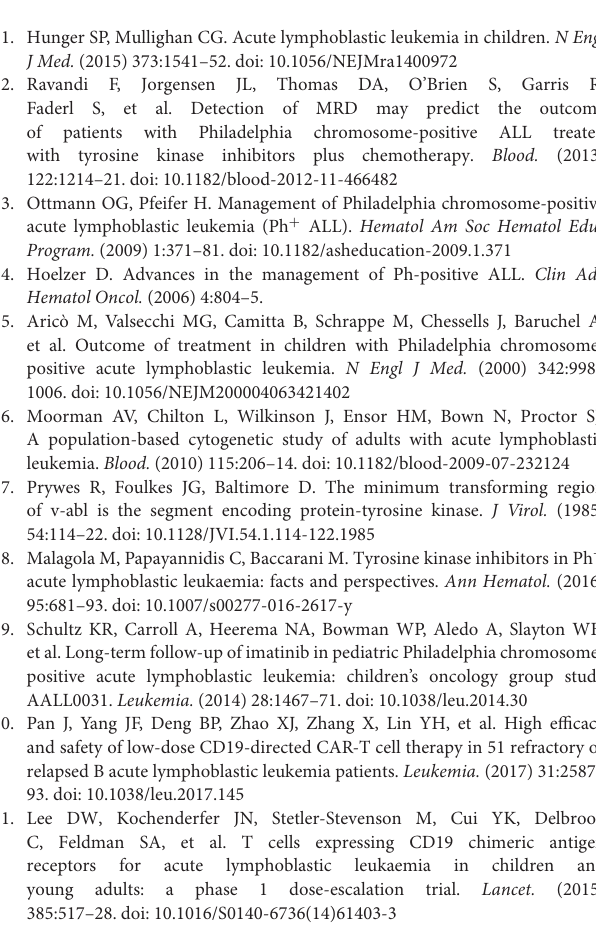
Supplementary Table 1 | Analytical performance parameters of the ddPCR assay. (A) Performance Parameters of the ddPCR P210 (e14a2) Assay by K562